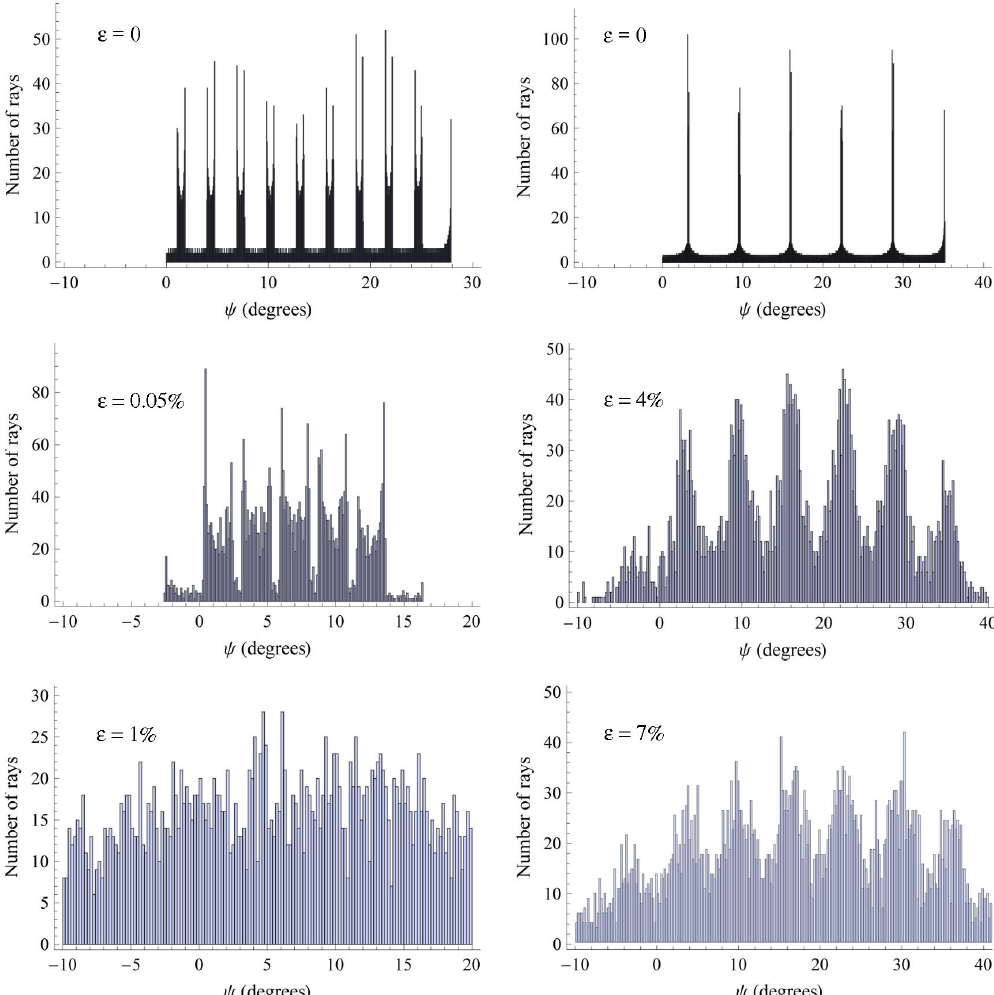
Fig. 5. Distributions of scattered rays on the Earth’s orbit for the geometry in Fig. 4 for different values of turbulence level ε . The left column of histograms corresponds to the fundamental emission ( f = 1 . 05 f p ,f p ≈ 4MHz ) , the right column – to the harmonic emission ( f = 2 f p ) . The values of the turbulence parameters: l i = 3km, l o = 4 . 1 × 10 5 km, l ∗ ≈ 2 . 3 × 10 3 km, and l = 2 . 2 l ∗ . The values of the CME regular structure parameters: Q = 7 . 5; ϕ l = 2 ◦ , δ = 7% (left column); ϕ l = 4 . 3 ◦ , δ = 50% (right